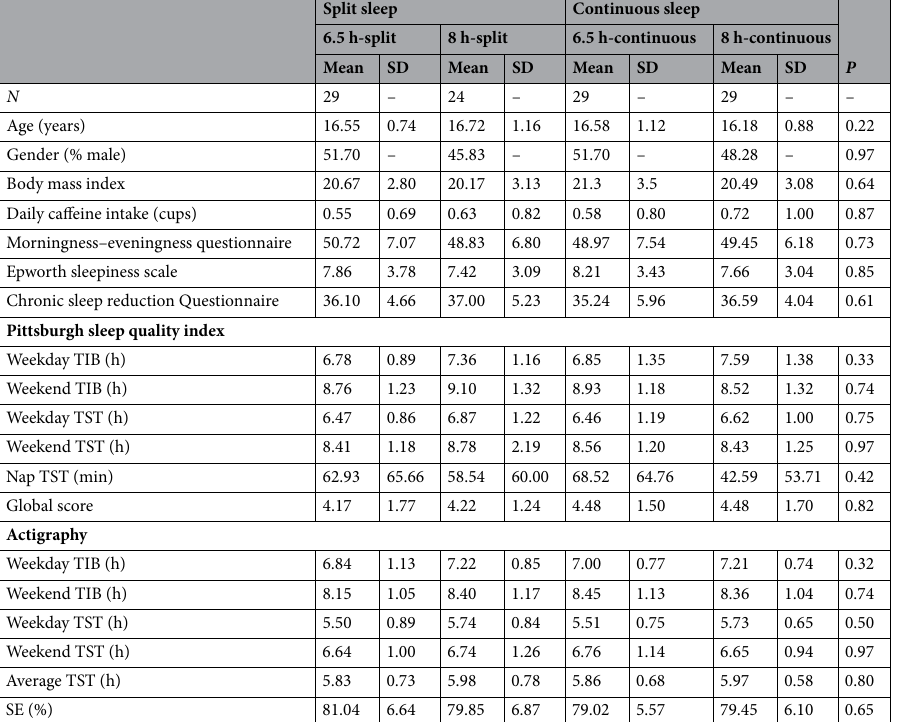
Table 1. Characteristics of split and continuous sleep groups prior to commencement of the experimental protocol. All measures were obtained during a briefing, except the actigraphic measures of habitual sleep that were acquired during a one week period after the briefing. TIB time in bed, TST total sleep time, SE sleep efficiency . P values from one-way ANOVA and Chi-squared tests contrasting the 4 groups are listed.